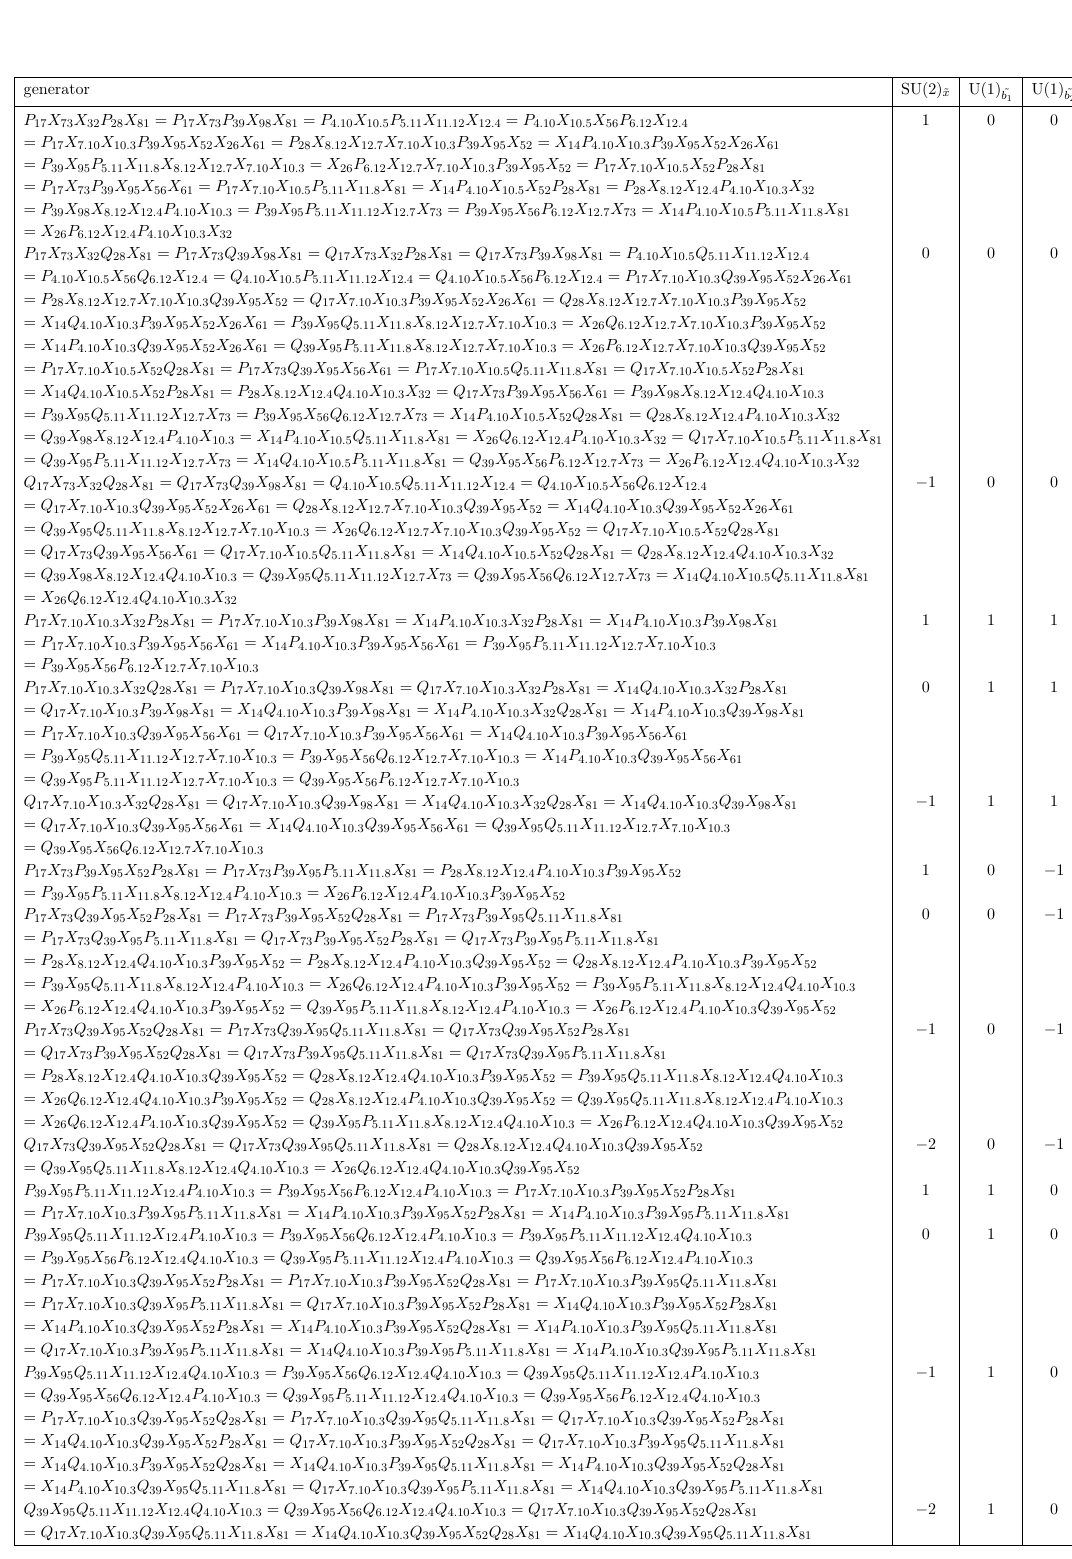
Table 74 . The generators in terms of bifundamental chiral fields for Model 18 (Part 2)